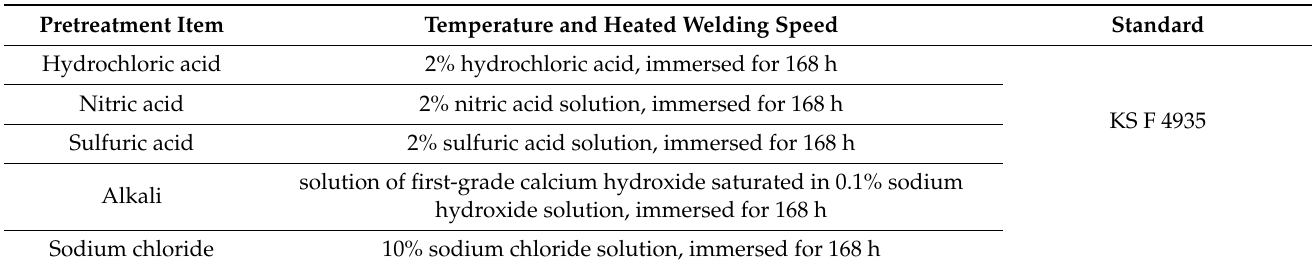
Table 6. The deterioration